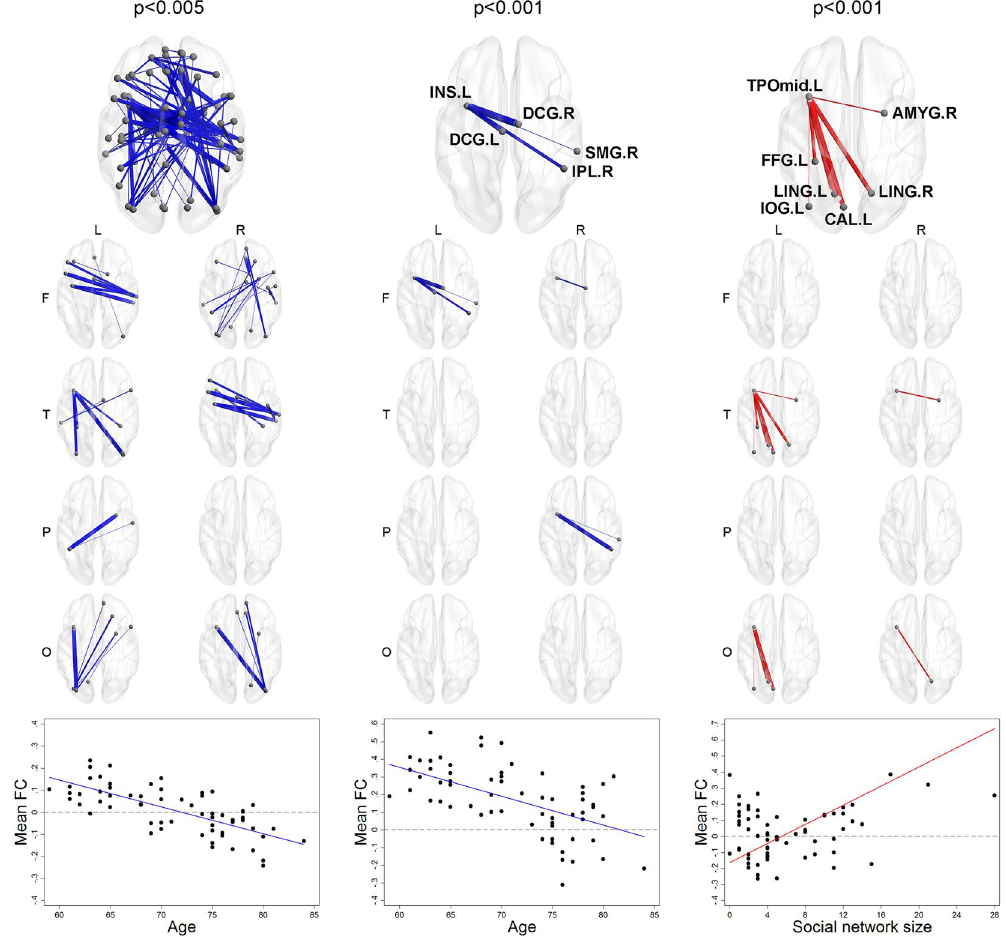
Figure 4. Component-level associations between functional connectivity and age/social network size. A brain figure for the whole component and eight separate figures for the regional connectivity from left/right frontal/temporal/parietal/occipital lobes are presented for each threshold. The largest component negatively associated with age at the thresholds of p < 0.01 or p < 0.005 had significantly larger extent and intensity than simulated networks, but not at the level of p < 0.001. As for social network size, the component only at the level of p < 0.001 had significantly larger intensity than simulated networks. Mean functional connectivity among the ROIs in each component was lower for those with higher age, and higher for those with the bigger social networks after controlling for other